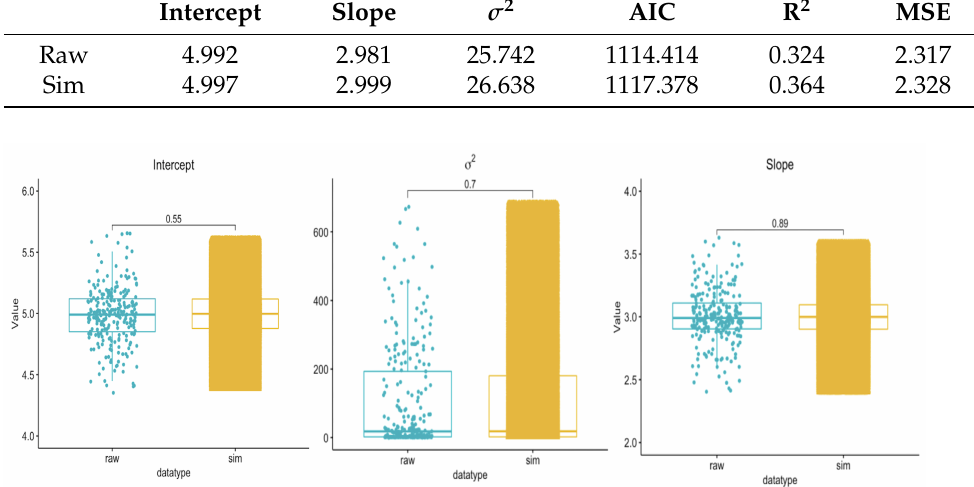
Figure 7. Boxplots for all replicates. Raw: Parameter estimates using data simulated by true parameter values. Sim: Parameter estimates using data simulated by the raw estimates. Overall the mean estimates between the raw and sim is insignificant. The p -values reported in plot are 0.55, 0.7, and 0.89 for intercept, σ 2 , and slope, respectively.